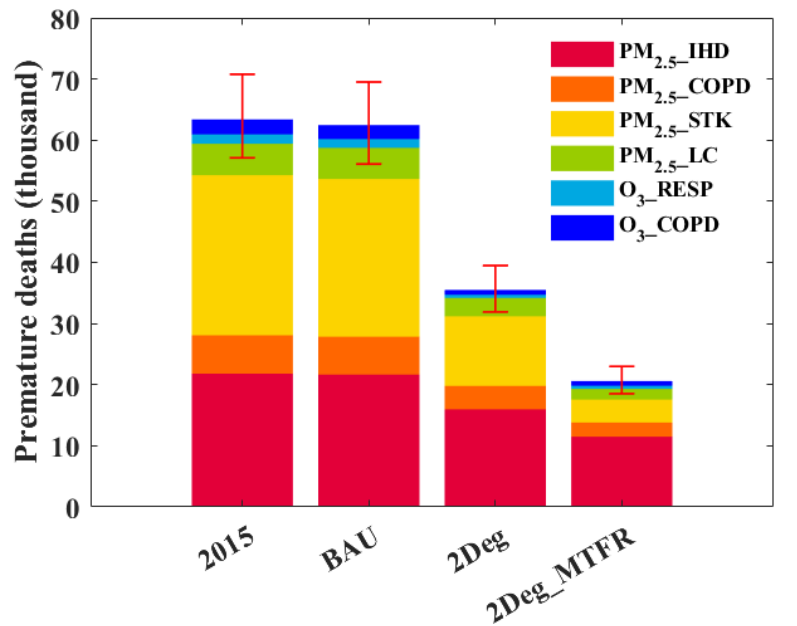
Figure 6. Premature deaths due to exposure to PM 2.5 and ozone under the different scenarios.